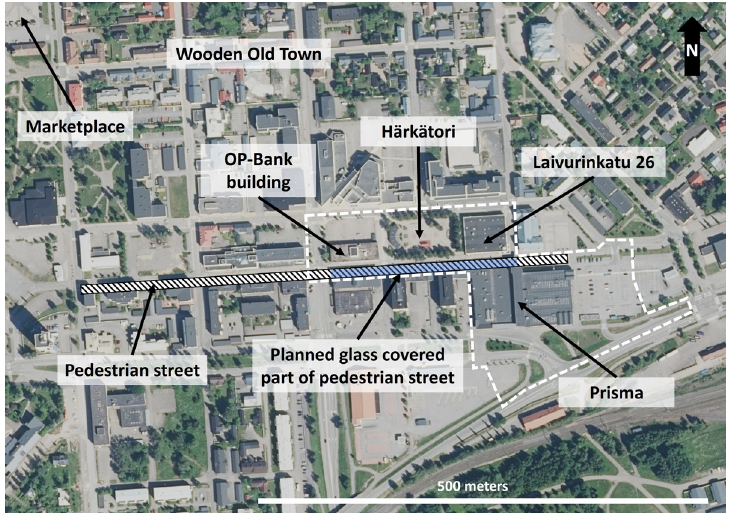
Fig. 5. Planned area in the commercial centre of Raahe. (Background: Maanmittauslaitos Ortokuva